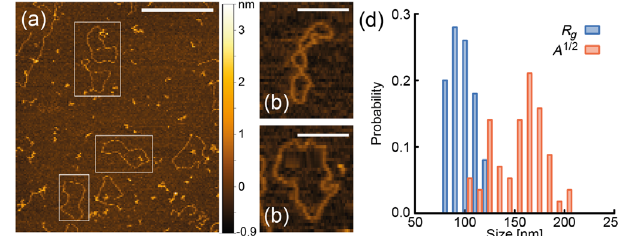
FIG. 2. (a) Examples of single rings used to compute the perimeter and radius of gyration of single minicircles. The scale bar is 500 nm. (b),(c) Enlargements of minicircles with supercoiledlike (b) and open (c) conformations. Scale bars are 250 nm. (d) Size of the minicircles, computed as the radius of gyration of the AFM traces, R , and the square root of the area, g ¼ 101 . 3 (cid:3) 10 . 8 nm, in line with A 1 = 2 . We find a mean R g ¼ 109 nm for 2.6-kb-long plasmids, and Ref. [29] reporting R g mean A 1 = 2 ¼ 154 . 4 (cid:3) 22 . 5